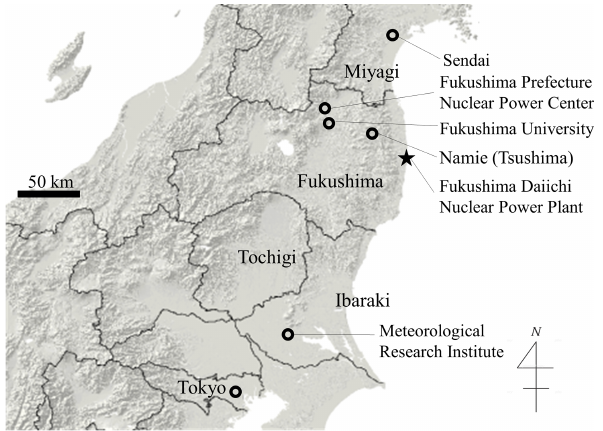
Figure 1. Map of Fukushima Prefecture and the surrounding pre- fectures. The locations mentioned in this study and the terrestrial elevations are depicted on the